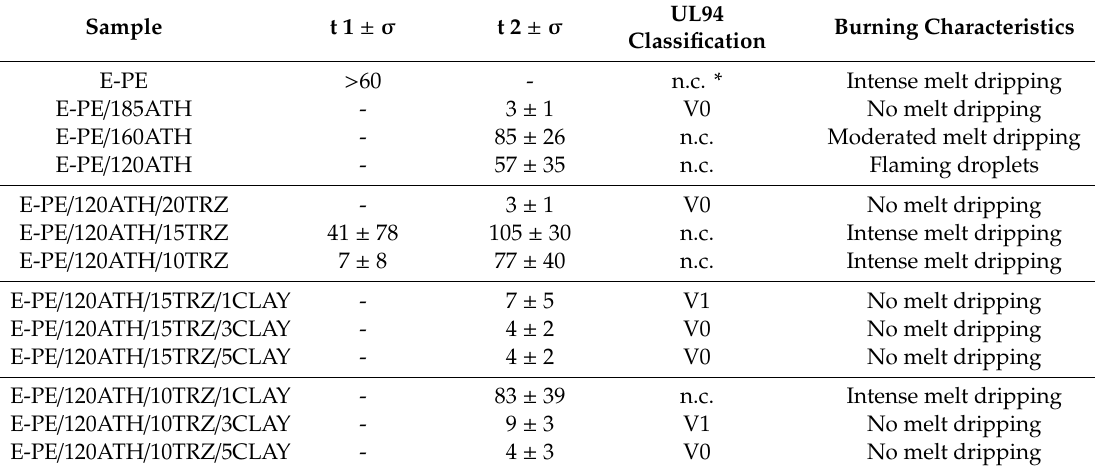
Table 3. Flammability results of E-PE blend and the investigated composites following the UL94 vertical configuration